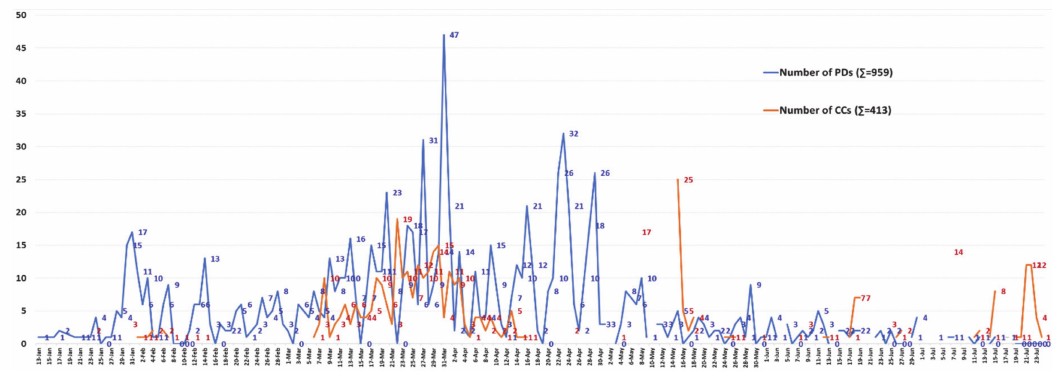
Figure 2. Numbers of CCs and PDs released (as of 24 July 2020).